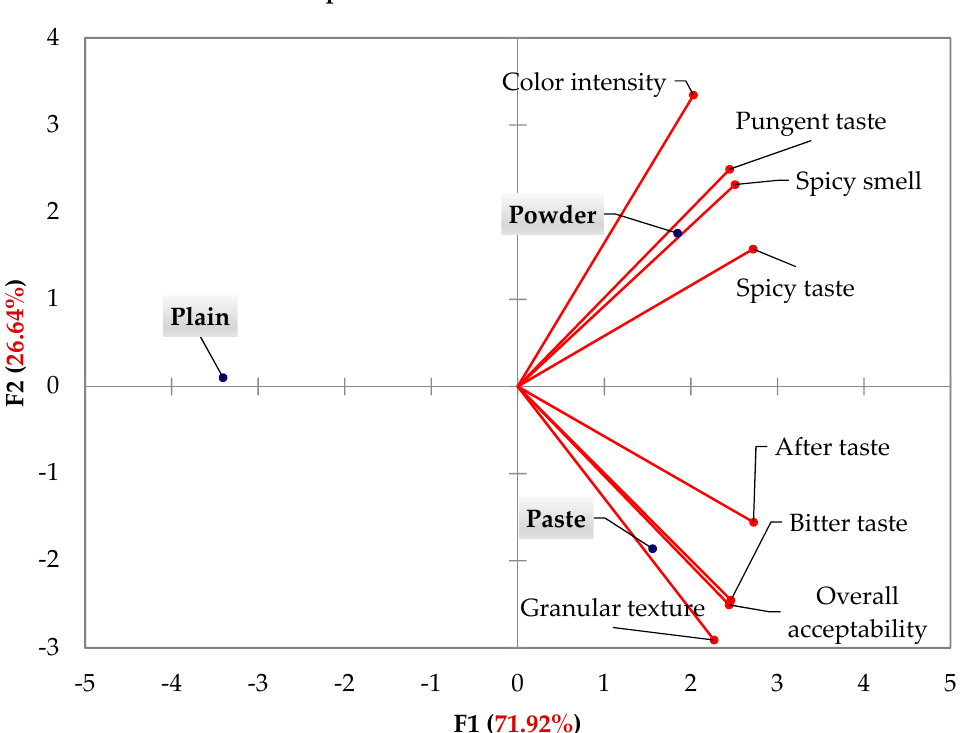
Figure 2. PCA biplot of the position of the three cheeses (plain and flavored with Allium roseum paste and powder) according to the sensory attributes evaluation.